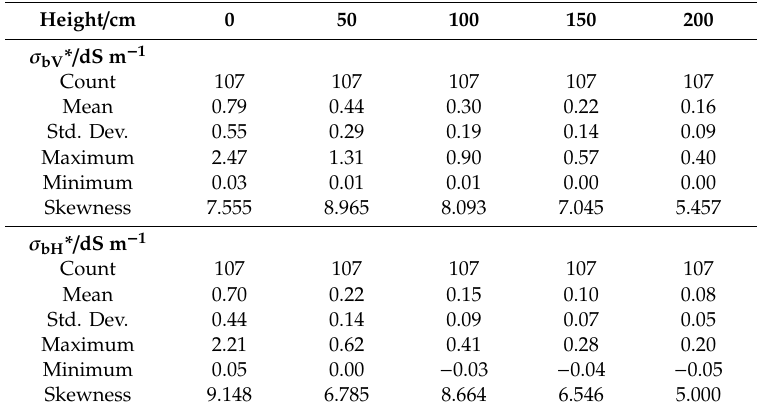
Table 5. Statistical summary of the soil depth-weighted electrical conductivity measurements taken in thestudyareawiththeEM38inthevertical( σ bV *)andhorizontal( σ bH *)dipolemodesatdi ff erentheights.